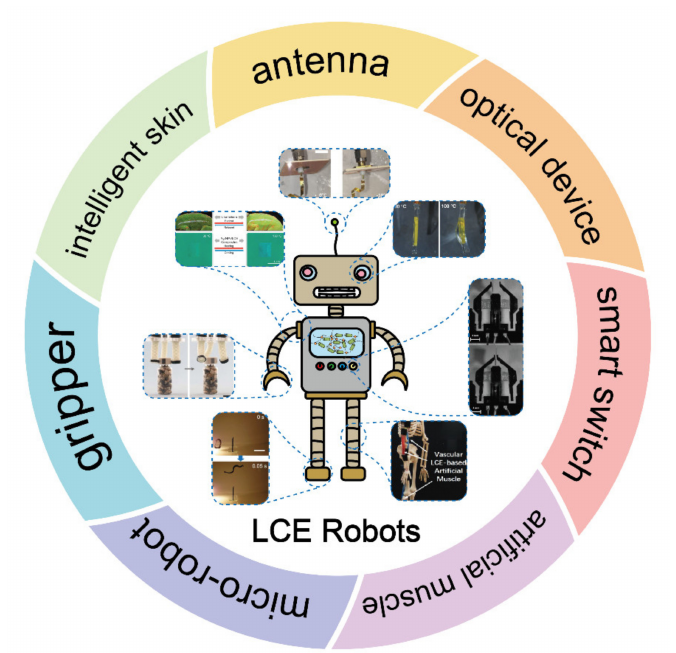
Figure 1. Applications of liquid crystalline elastomers in optical device [11] (Reproduced with per- mission from L ó pez-Valdeolivas, M.; Liu, D.; Broer, D.J.; S á nchez-Somolinos, C., Macromol. Rapid Commun.; Copyright 2018 John Wiley and Sons.), smart switches [34] (Reproduced with permission from S á nchez-Ferrer, A.; Fischl, T.; Stubenrauch, M.; Wurmus, H.; Hoffmann, M.; Finkelmann, H, Macromol. Chem. Phys.; Copyright 2009 John Wiley and Sons.), artificial muscles [35] (Reproduced with permission from He, Q.; Wang, Z.; Song, Z.; Cai, S., Adv. Mater. Technol.; Copyright 2019 John Wiley and Sons.), micro-robots [36] (Reproduced with permission from Ahn, C.; Liang, X.; Cai, S., Adv. Mater. Technol.; Copyright 2019 John Wiley and Sons.), soft grippers [37] (Reproduced with permission from He, Q.; Wang, Z.; Wang, Y.; Minori, A.; Tolley, M.T.; Cai, S., Science Advances; Copy- right 2019 American Association for the Advancement of Science.), intelligent skins [38] (Adapted from Ref. [38] with permission from the Centre National de la Recherche Scientifique (CNRS) and The Royal Society of Chemistry.), and antennas [39] (Adapted with permission from Kim, H.; Gibson, J.; Maeng, J.; Saed, M.O.; Pimentel, K.; Rihani, R.T.; Pancrazio, J.J.; Georgakopoulos, S.V.; Ware, T.H. Re- sponsive, 3D Electronics Enabled by Liquid Crystal Elastomer Substrates. ACS Appl. Mater. Interfaces 2019, 11, 19506–19513, doi:10.1021/acsami.9b04189. Copyright (2019) American Chemical